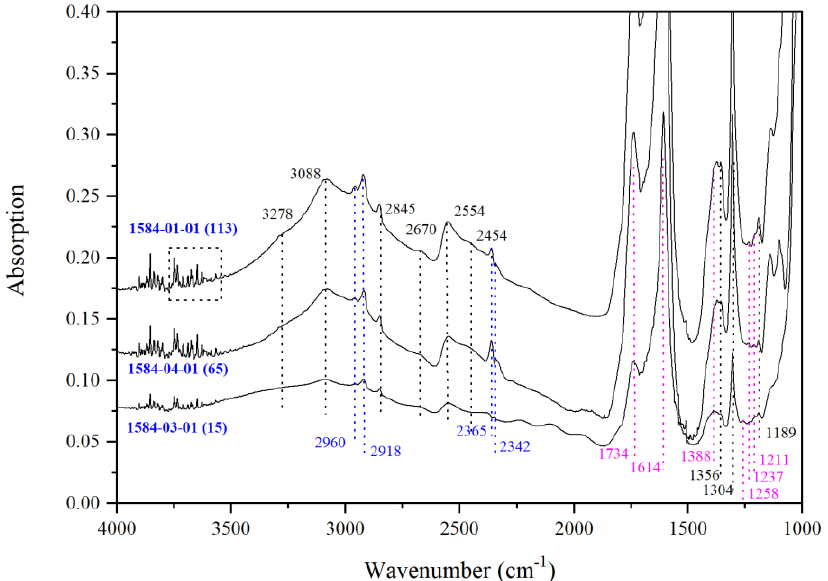
Figure 6. Typical unpolarized IR spectra taken on three crystal plates made from the low-H 2 O Mg-Rw in Run 1584. The IR # is followed by the measured thickness of the crystal plate ( D m in parentheses). Note the interference fringes around ~2150 cm − 1 in the spectrum 1584-03-01, which can be used to calculate the thickness. The peaks at ~2365 and 2342 cm − 1 are due to the CO 2 in air, whereas those at ~2960 and 2918 cm − 1 are due to the acetone residue.